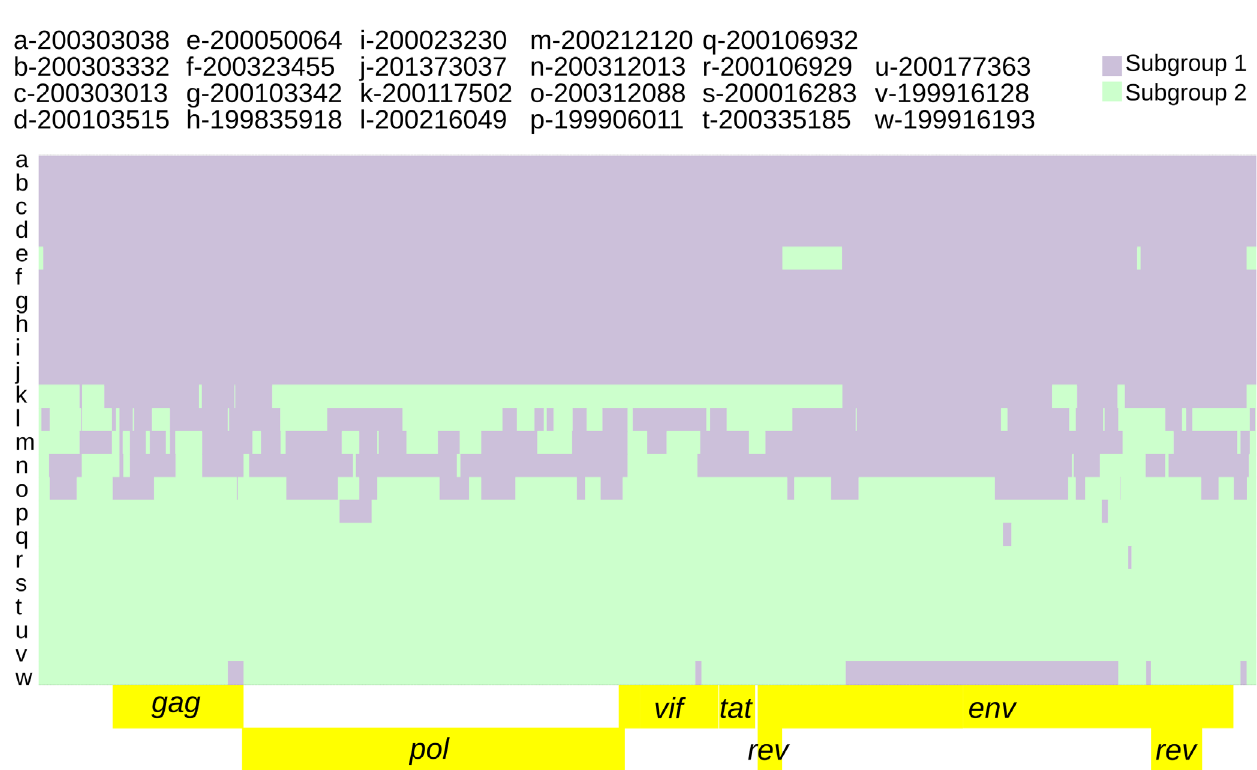
Figure 4. Twenty-three SRLV subtype A2 genomes ‘painted’ with recipient genomic ‘chunks’ derived from subgroup-specific donor genomes. The recombination model utilized was subgroup1 vs subgroup